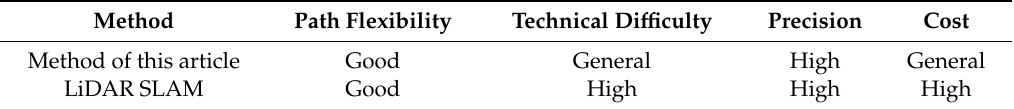
Table 6. Comparison between the method of this article and the LiDAR SLAM localization